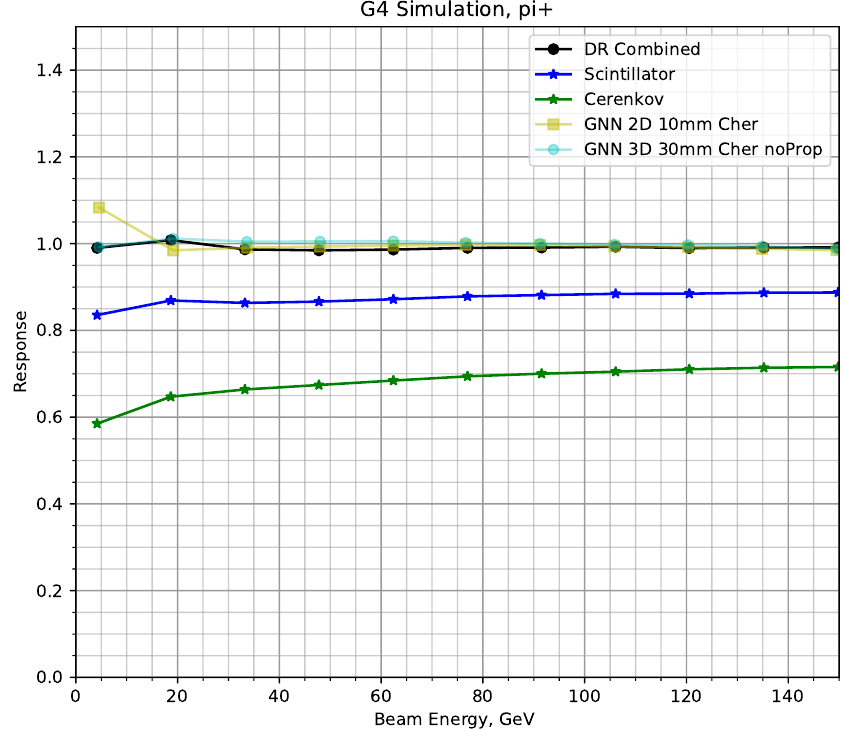
Figure 5. Response of the calorimeter to 4–150 GeV π + : (green) the simple sum of the Cherenkov signal, (blue) simple sum of scintillation signal, (black) dual-readout method, (yellow) GNN 2D reconstruction, and (light blue) GNN 3D reconstruction. In all cases, the calorimeter is calibrated with electrons and the signal distributions are fitted by a Gaussian